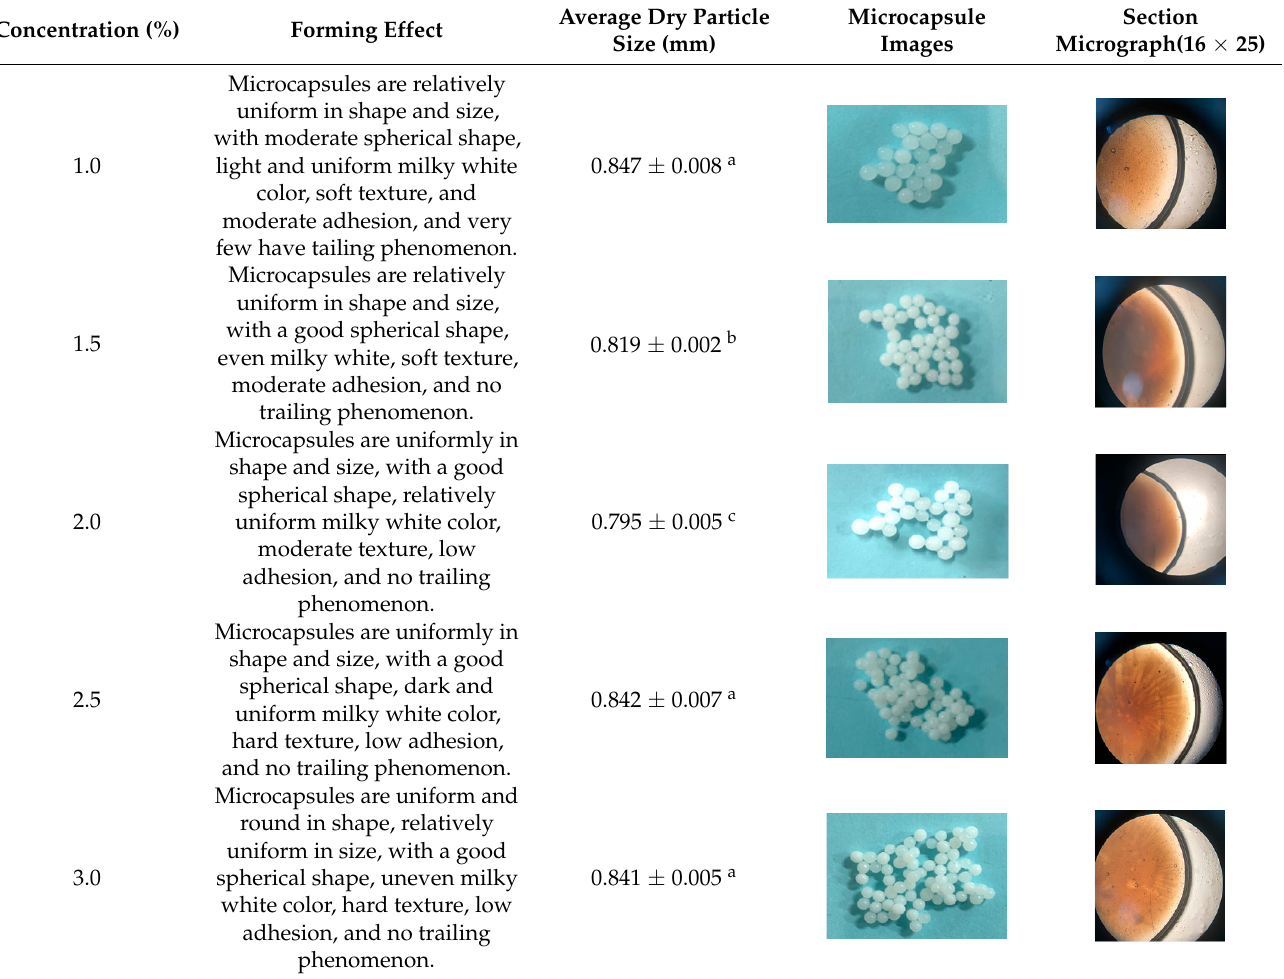
Table 3. Effect of CaCl 2 concentration on microcapsule formation.